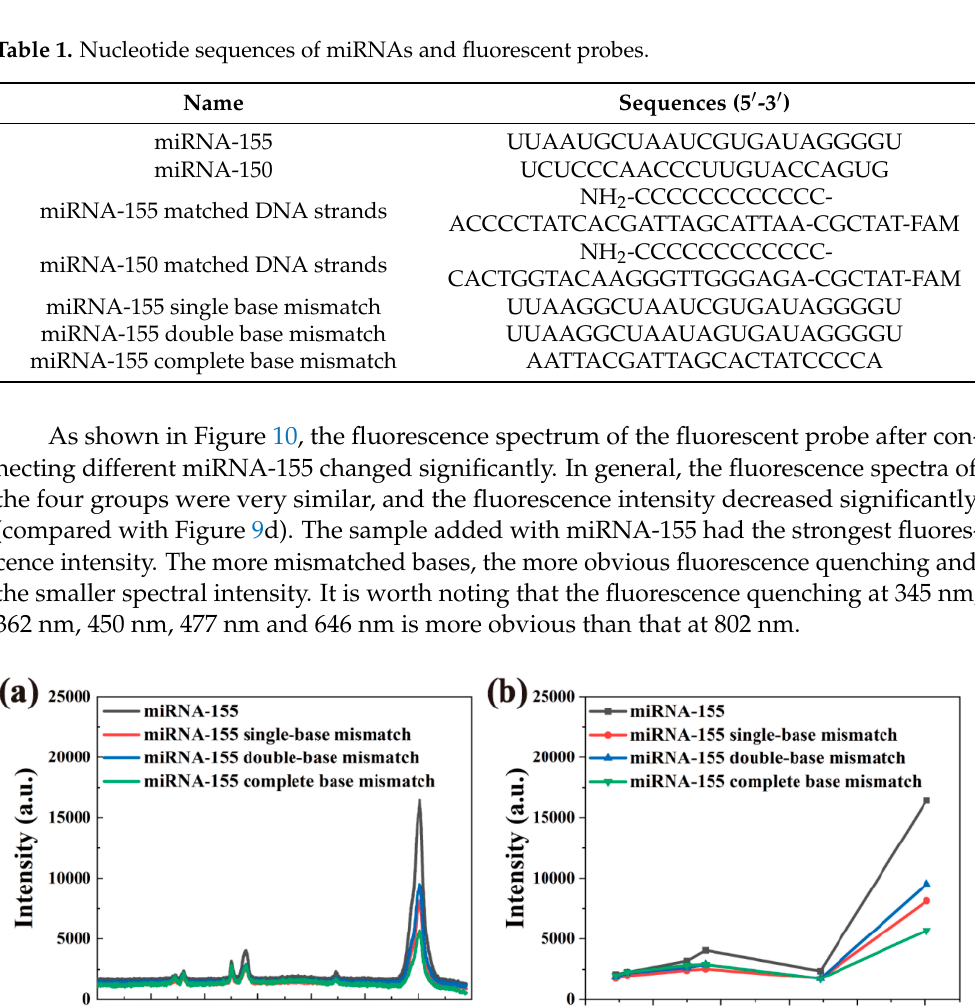
Table 2. The ratio of fluorescence peaks at 802 nm and 450 nm.